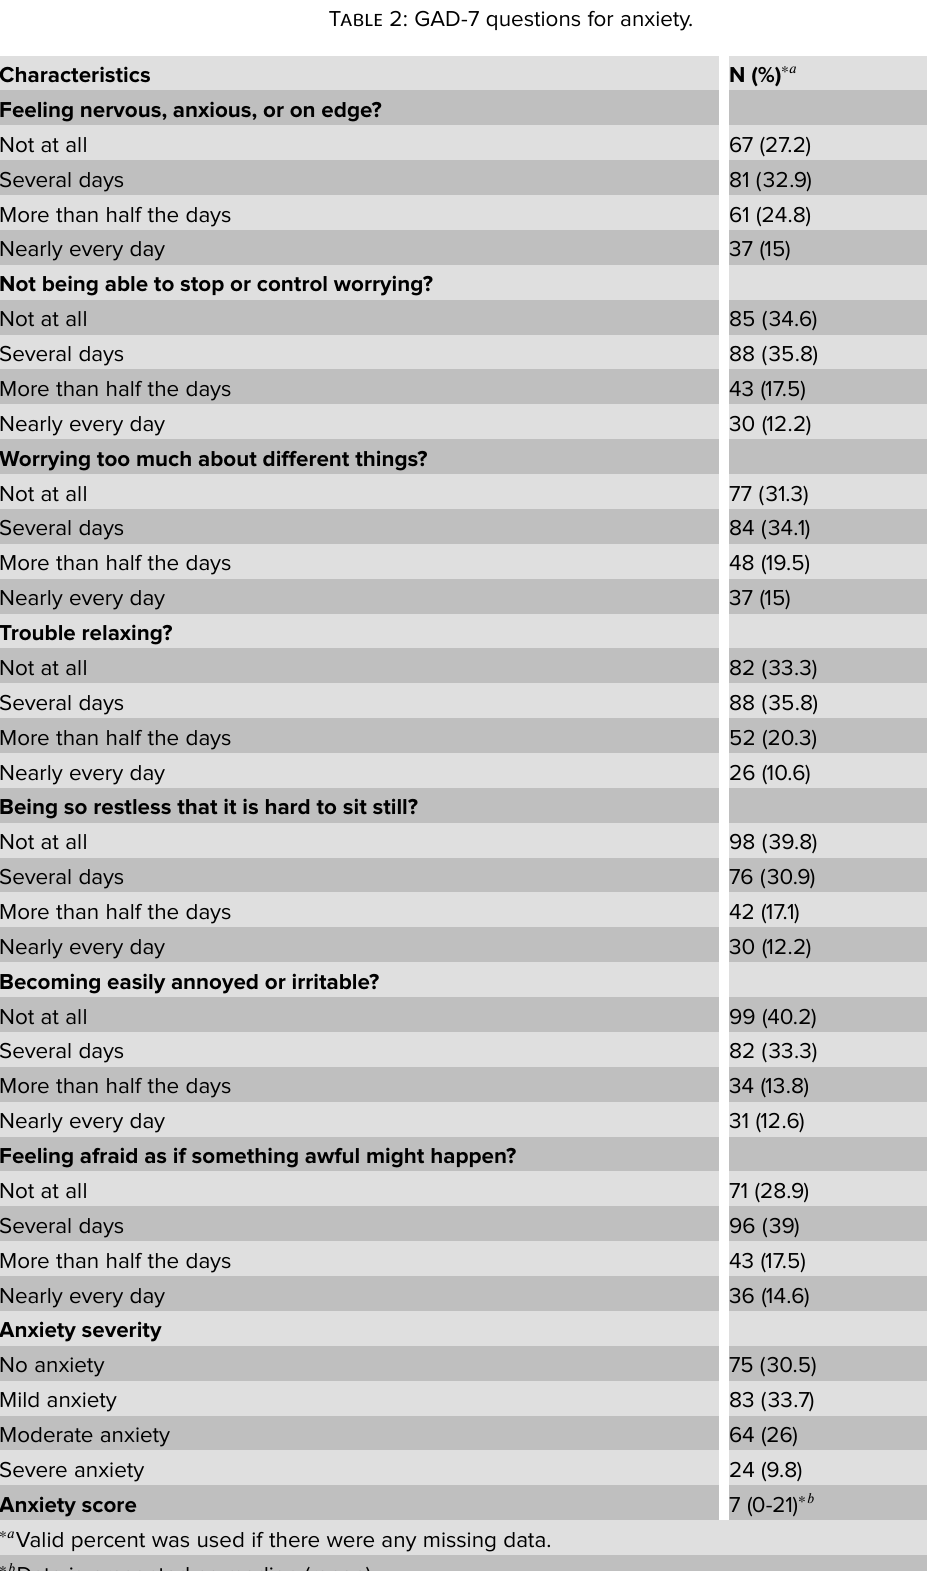
Table 2: GAD-7 questions for